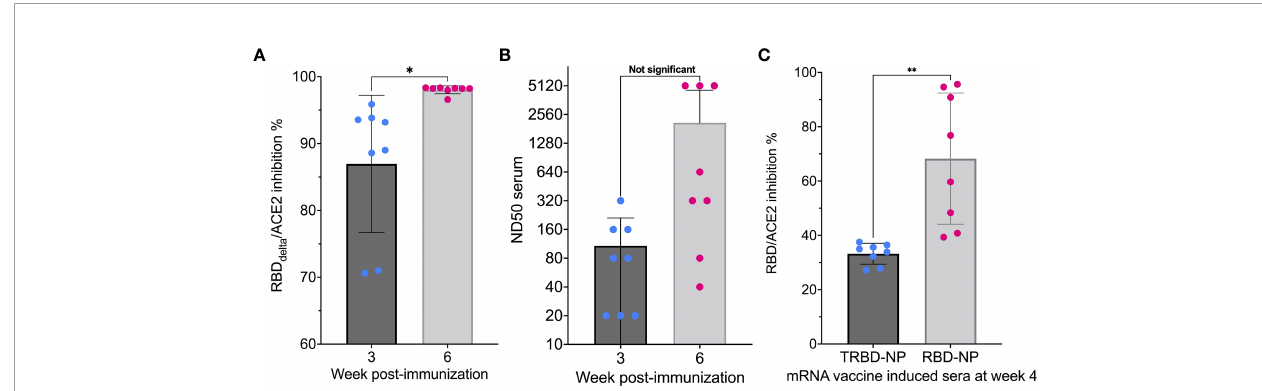
FIGURE 3 | Induction of neutralizing activity after immunization: (A) RBDDelta-ACE2 interaction inhibition by neutralizing antibodies in mice Sera samples analyzed with the SARS-CoV-2 neutralization antibody detection assay. RBD Delta -ACE2 interaction inhibition rate at week 3 and 6 in CB6F1/J female mice (n= 8). Week 3 and 6 were signi fi cantly different in two-tailed paired t-test ( p -value= 0.016). (B) SARS-CoV-2 Delta variant neutralization in mice Sera samples analyzed with the SARS- CoV-2 Delta variant neutralization test. Median neutralization dose (ND50) at week 3 and 6 in CB6F1/J female mice (n= 8). BNT162b2-elicited human sera as reference. Week 3 and 6 were not signi fi cantly different in two-tailed paired t-test ( p -value= 0.063). (C ) Inhibition of RBD-ACE2 interaction by mRNA RBD-NP vaccine requires full-length RBD Eight-week-old CB6F1/J female mice were primed at week 0 and boosted at week 2 by needle-free i.m. injection at the caudal thigh with the modi fi ed Tropis ® injector and the same dose (42µg/50µl) of two different mRNA vaccines. Group 1 (n= 8) received the mRNA RBD-NP vaccine with wild type RBD. Group 2 (n= 8) received the mRNA TRBD-NP vaccine with the truncated RBD. Serum samples collected at week 4 were analyzed with the SARS-CoV-2 neutralization antibody assay. Inhibition rates of RBD-ACE2 interaction with sera induced by the mRNA TRBD-NP vaccine and the mRNA RBD-NP vaccine were signi fi cantly different in two-tailed unpaired t-test ( p -value= 0.0012). *p ≤ 0.05, **p ≤